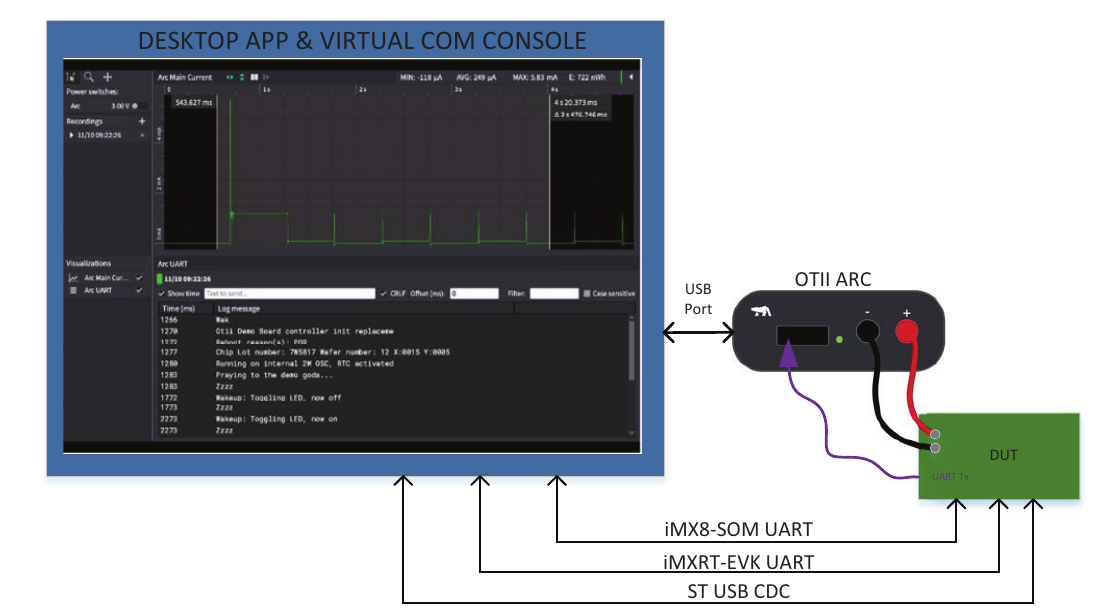
Figure 8. Implemented setup for the power consumption